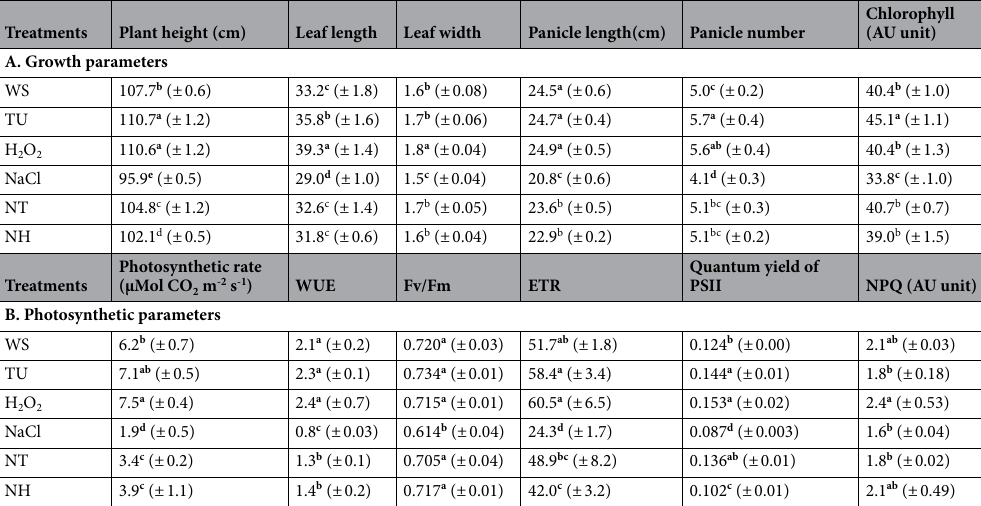
Table 1. Quantification of various growth [A] and PS-II related photosynthesis parameters [B] under different treatment conditions . Total three foliar applications were given at vegetative, early anthesis and grain filling stages that corresponded to 40, 55 and 72 days post-transplantation, respectively. The quantitation was done after 5 days of 3rd foliar spray. The main flag leaf was taken for the analysis of photosynthetic parameters. Different treatment includes WS (DW + 0.01% Tween-20), TU (6.5 mM TU + 0.01% Tween-20) and H 2 O 2 (10 mMH 2 O 2 + 0.01% Tween-20), NaCl (22 g NaCl per pot). For NT and NH, a combined treatment of NaCl + TU and NaCl + H 2 O 2 treatments were also given respectively. The values represent mean of ten biological replicate ± SE. Different letter indicates significantly different values (DMRT, p ≤ 0.05